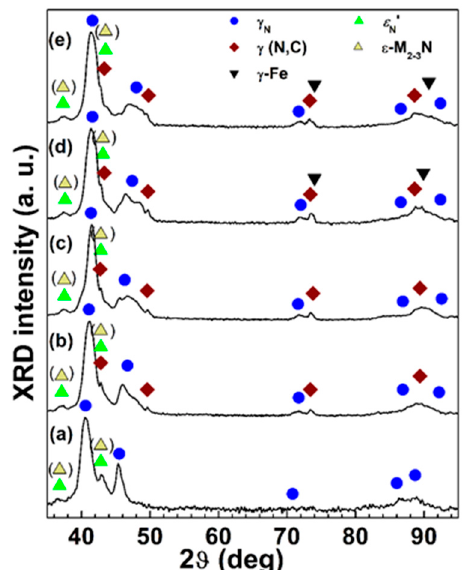
Figure 2. Micrographs of the modified surface layers of samples nitrided at 380 °C, 3 h, 50 vol.% N 2 + 50 vol.% H 2 ( a ), at 360 °C, 50 vol.% N 2 + 50 vol.% H 2 , for 1 ( b ), 3 ( c ), and 5 ( d ) h. (Cross-section; etchant: acetic glyceregia).